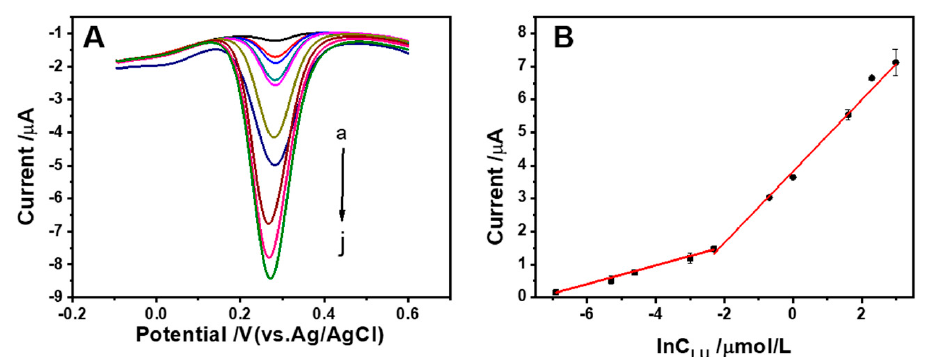
Figure 7. ( A ) Differential pulse voltammetry (DPV) of UiO-66/ErGO/GCE in 0.1 M PBS (pH = 6.0) with different LU concentrations from a to j (0.001, 0.005, 0.01, 0.05, 0.1, 0.5, 1, 5, 10 and 20 μ M). ( B ) The corresponding calibration curves between Ipa and LU concentrations for UiO-66/ErGO/GCE. Table 1. Comparison of the performance of UiO-66/ErGO/GCE with other reported LU sensors. LU Sensors